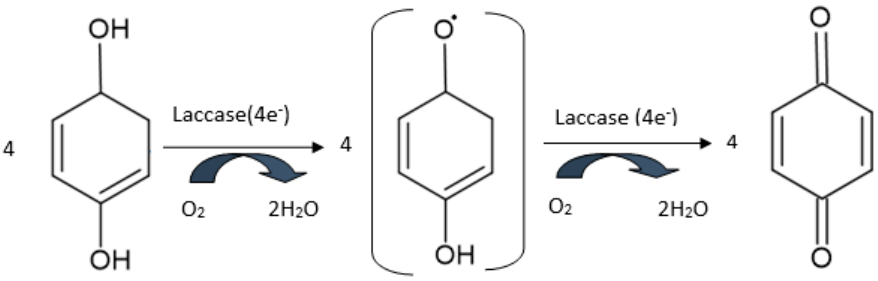
Figure 6. The oxidation reaction of phenolic compounds catalyzed by the laccase enzyme.